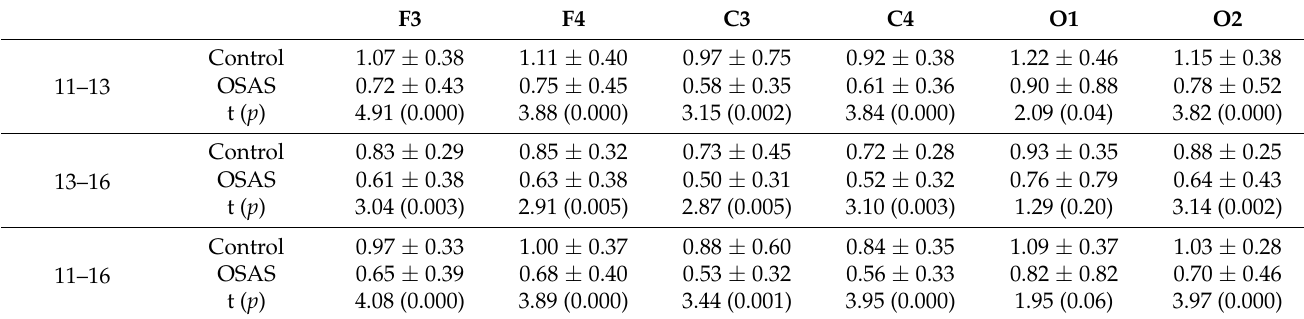
Table 3. Power spectral density results for OSAS and control groups.